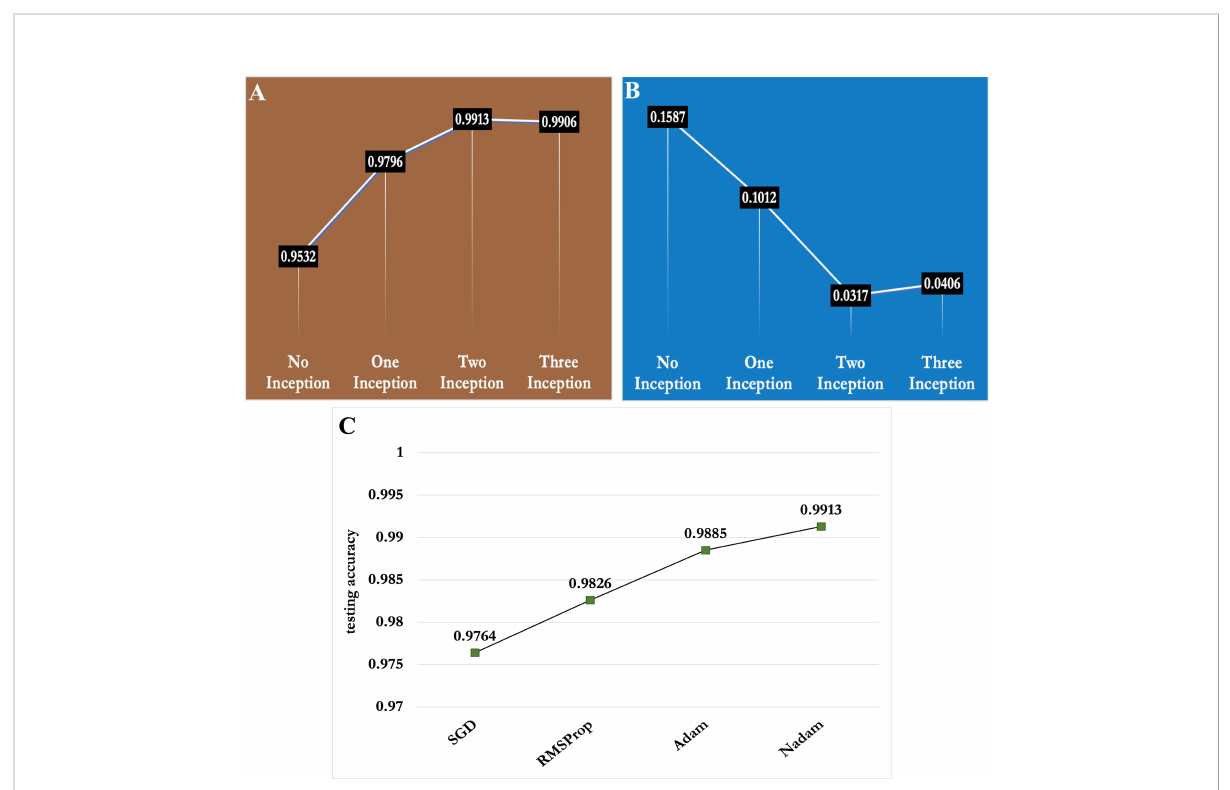
FIGURE 10 Depiction of the effect of number of Inception modules and optimization functions in performance of the proposed CNN model (A) Number of Inception modules vs classi fi cation accuracy (B) Number of Inception modules vs testing loss and (C) Optimization functions vs classi fi cation accuracy